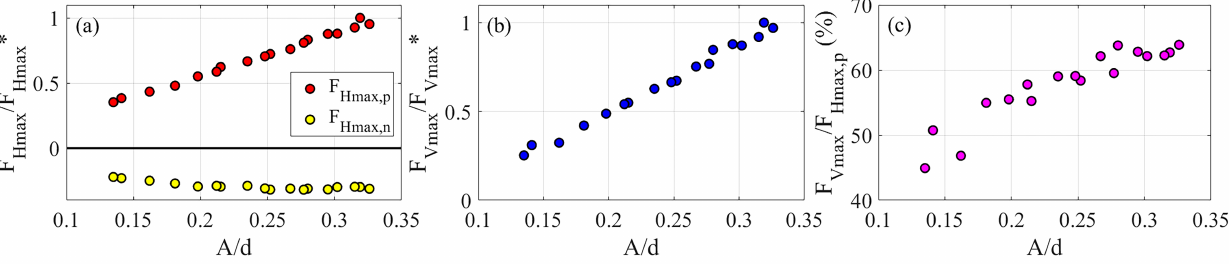
Figure 7. Maximum positive and negative wave forces vs. A / d . ( a ) Horizontal force; ( b ) vertical force; ( c ) weight of the vertical force with respect to the horizontal